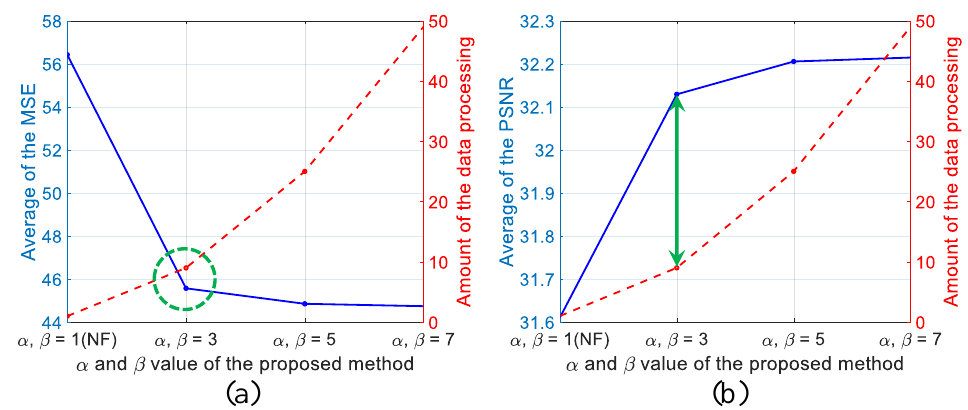
Figure 8. Comparison between the data processing time and filtering effect using ( a ) MSE and ( b ) PSNR. Blue line means result of each metric and red dotted line means amount of the data processing.